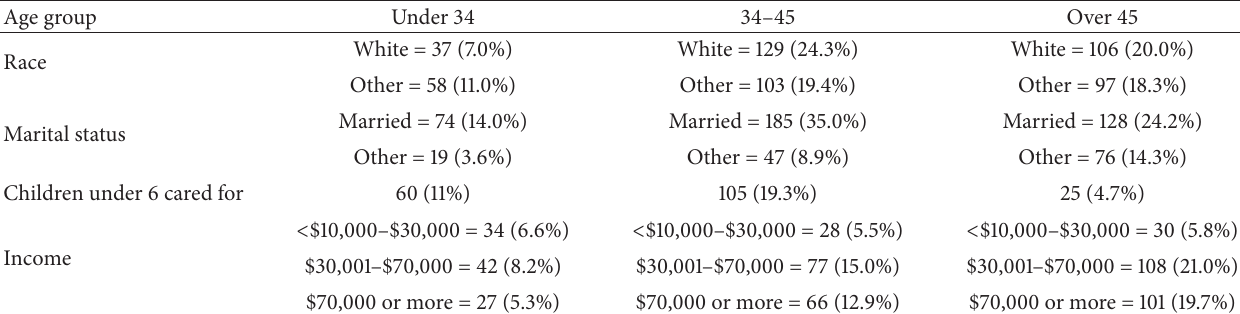
Table 1: Prevalence of categorical caregiving and demographics by age group, drinkers only.